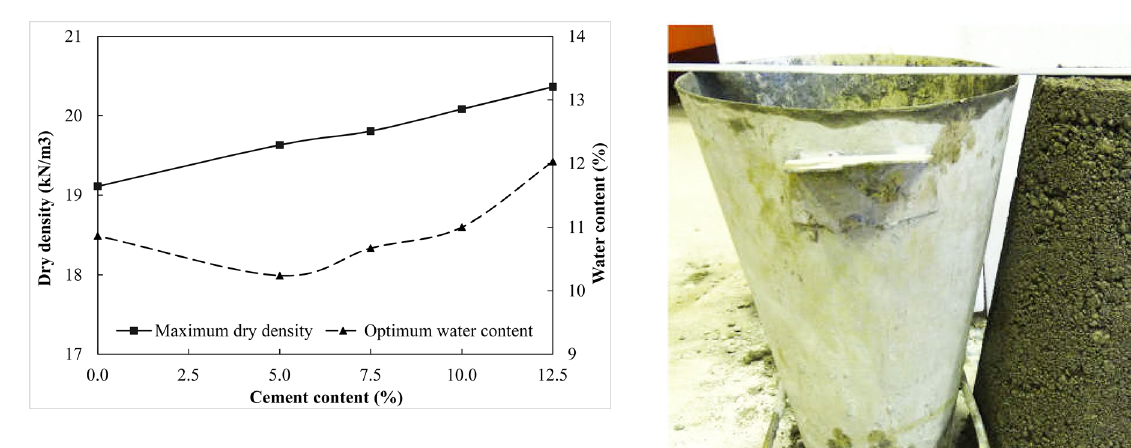
Fig. 6 The graph of MDD and OWC for the CSG mixtures with dif- ferent cement contents